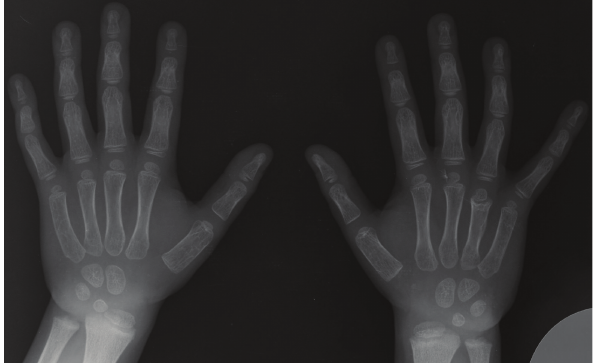
Figure 4: 3-year posttreatment radiographs showing discrete shortening of the right hand fourth